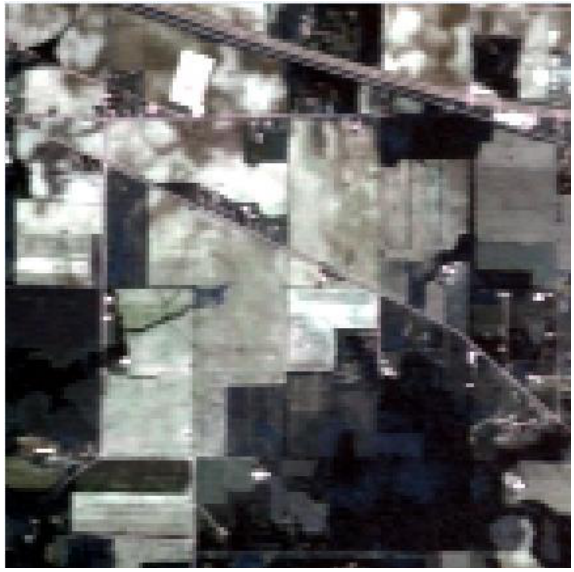
Figure 2: Study area image in false colours.